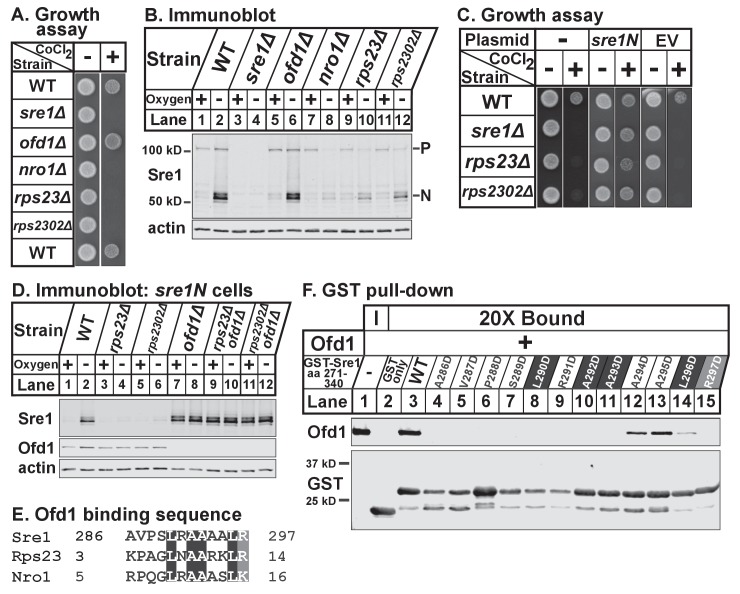
Unassembled Rps23 regulates Ofd1 inhibition of Sre1N.(A) Indicated strains were grown on rich medium in the absence and presence of 1.6 mM cobalt chloride and imaged after 3 and 4 days, respectively (5000 cells per spot). Shown are representative images from one of two independent experiments. (B) Indicated strains were cultured in rich medium in the presence or absence of oxygen for 3 hr. Whole cell extracts (20 μg) were treated with alkaline phosphatase and analyzed by immunoblot with antibodies against Sre1 and actin. P=precursor; N=nuclear. Shown are representative blots from one of two independent experiments. (C) Wild-type, sre1Δ, rps23Δ, and rps2302Δ cells were transformed with EV or CaMV-sre1N expressing vector and grown on rich medium for 3 days or rich medium containing 1.6 mM cobalt chloride (CoCl2) for 6 days (5000 cells per spot). Shown are representative images from one of two independent experiments. (D) Indicated sre1N strains were cultured in rich medium in the presence or absence of oxygen for 3 hr. Whole cell extracts (20 μg) were phosphatase-treated and analyzed by immunoblot with antibodies against Sre1, Ofd1, and actin. Shown are representative blots from one of two independent experiments. (E) Multiple sequence alignment of Sre1 aa 286–297, Rps23 aa 3–14, and Nro1 aa 5–16. (F) Lysates from bacteria expressing wild-type or mutant GST-Sre1 aa 271–340 were incubated with glutathione beads and then with purified Ofd1 (84.5 nM). Input and bound fractions were analyzed by immunoblot using antibodies against Ofd1 and GST. Shown are representative blots from one of two independent experiments.